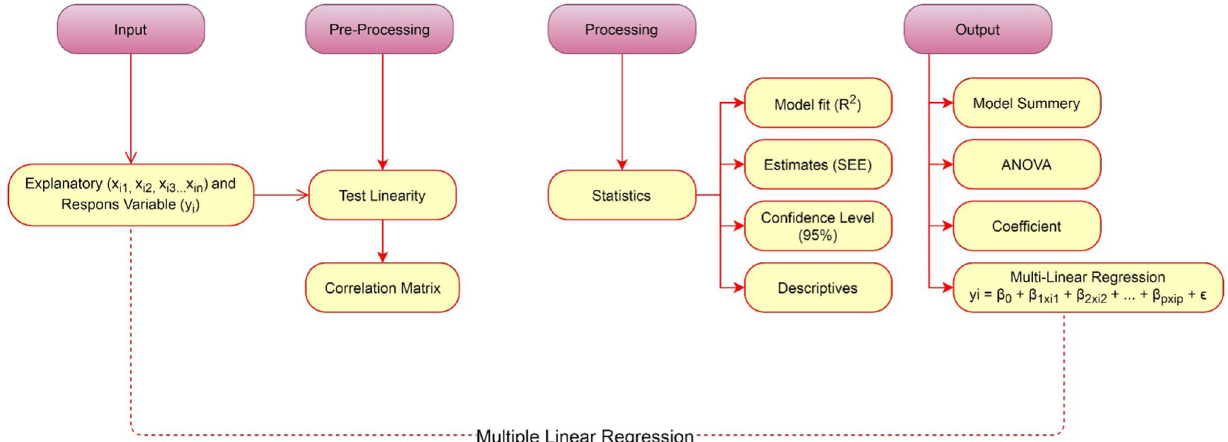
Fig. 9 Schematic presentation of multi linear regression